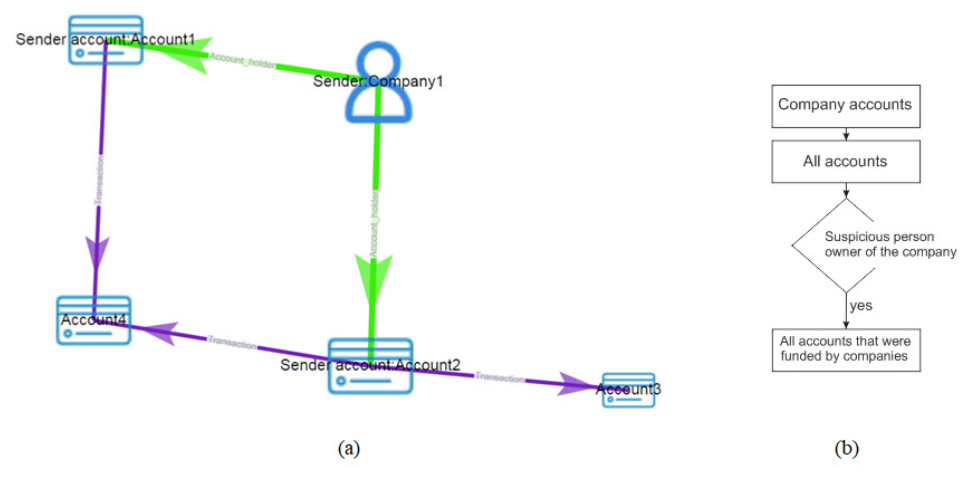
Figure 4. ( a ) Accounts credited from accounts held by companies‘ transactions and ( b ) the flowchart of the used Cypher query.